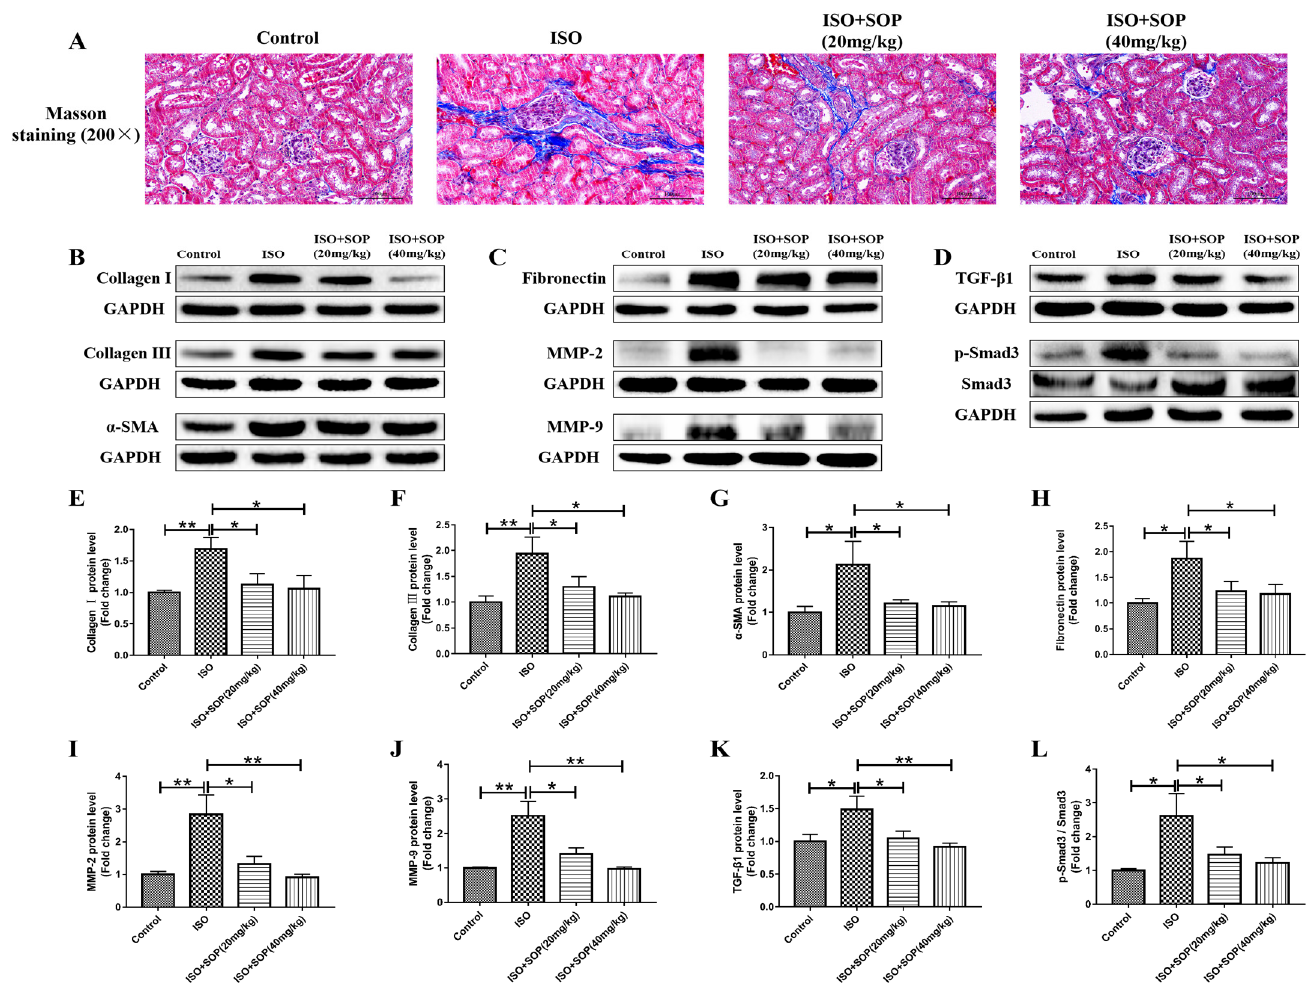
Figure 5. ( A ) A Masson staining assay was used to evaluate the fibrosis area in kidney tissues (n = 7–8). ( B , C , E – J ) The protein expression levels of fibrosis-related proteins such as collagen I, collagen III, α -SMA, fibronectin, MMP-2 and MMP-9 were detected using a Western blotting assay (n = 7–8). ( D , K , L ) The protein expression levels of TGF- β 1 and p-Smad3 were also detected using a